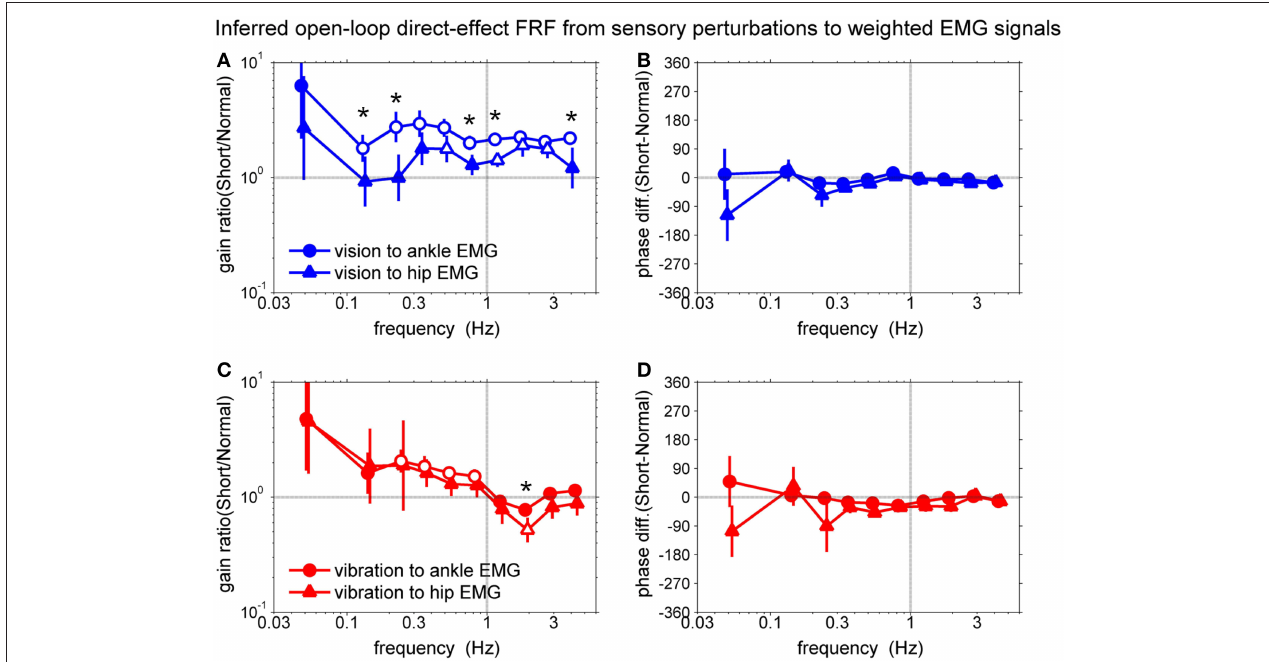
FIGURE 7 | Comparison of the open-loop direct-effect FRF from sensory perturbations to weighted EMG signals. (A) gain ratio of direct-effect FRFs from vision to EMGs, (B) phase difference of direct-effect FRFs from vision to EMGs, (C) gain ratio of direct-effect FRFs from vibration to EMGs, (D ) phase difference of direct-effect FRFs from vibration to EMGs. Open symbols represent significant differences between surface conditions and asterisks represent significant differences between two FRFs based on the bootstrap 95%